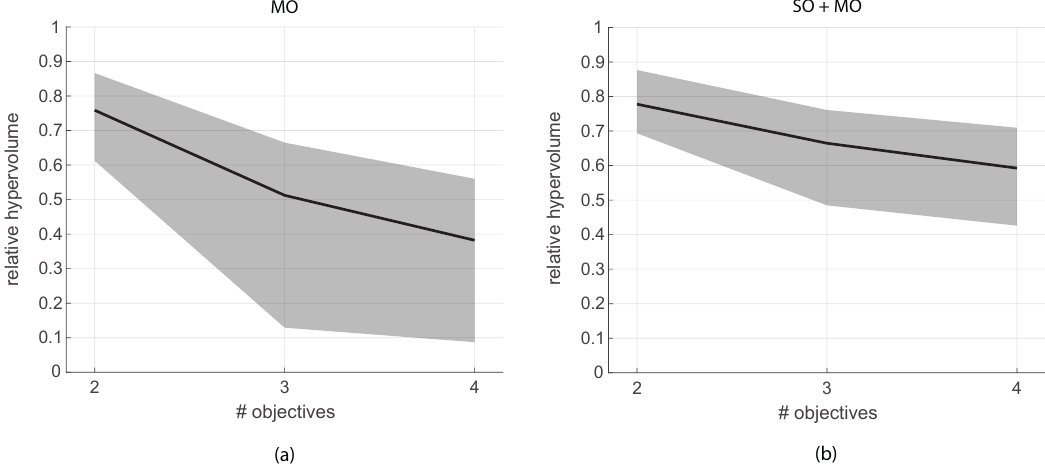
Figure 7. Average relative hypervolume (black line) and corresponding variability bound (grey area) obtained solving the DTLZ #2 problem for an increasing number of objectives. Panel ( a ) reports the performance of the MO algorithm, panel ( b ) of the SO+MO